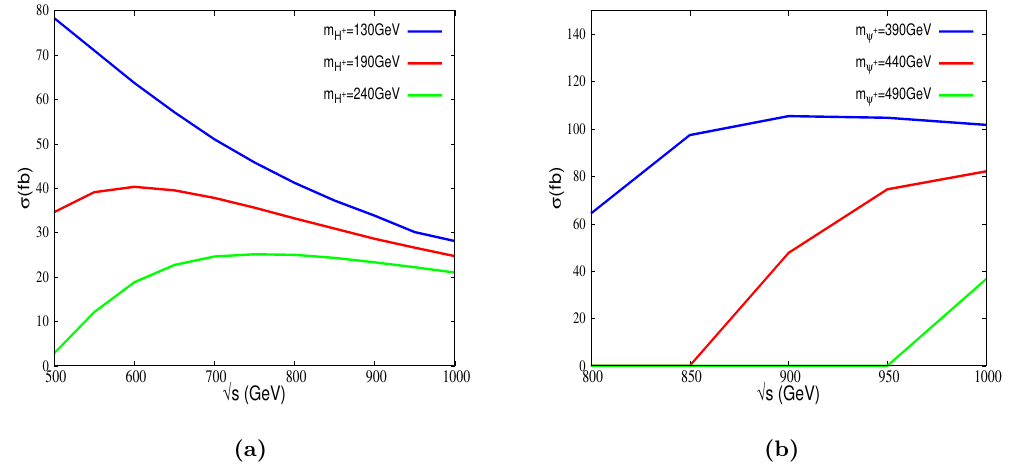
Figure 9. Production cross-section of HDSP pair for (a) scalar φ + φ − and (b) fermion ψ + ψ − as a √ function of s for different choices of HDSP masses at ILC. We use unpolarized initial beams. All the relevant couplings for the production of HDSP’s are given in eqs.